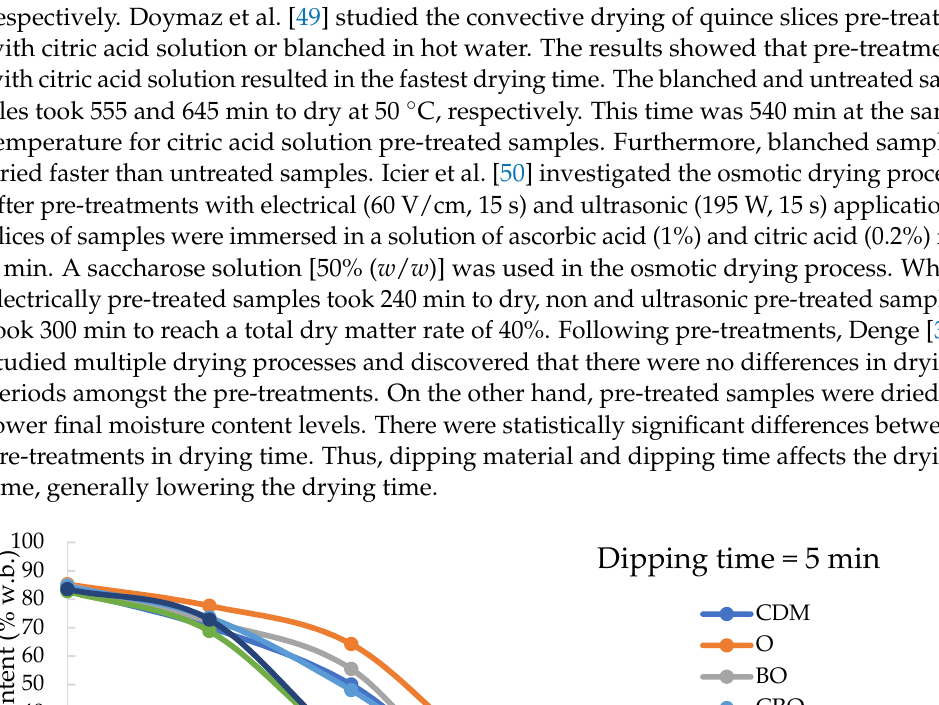
Figure 5. Effect of 5 min dipping time on drying time of different pre-treatments (tangerine ( Citrus deliciosa Mediterranean) (CDM); orange (O); bitter orange (BO); tangerine ( Citrus reticulate Owari ) (CRO); pomegranate (P); non-pre-treatment (NP)).